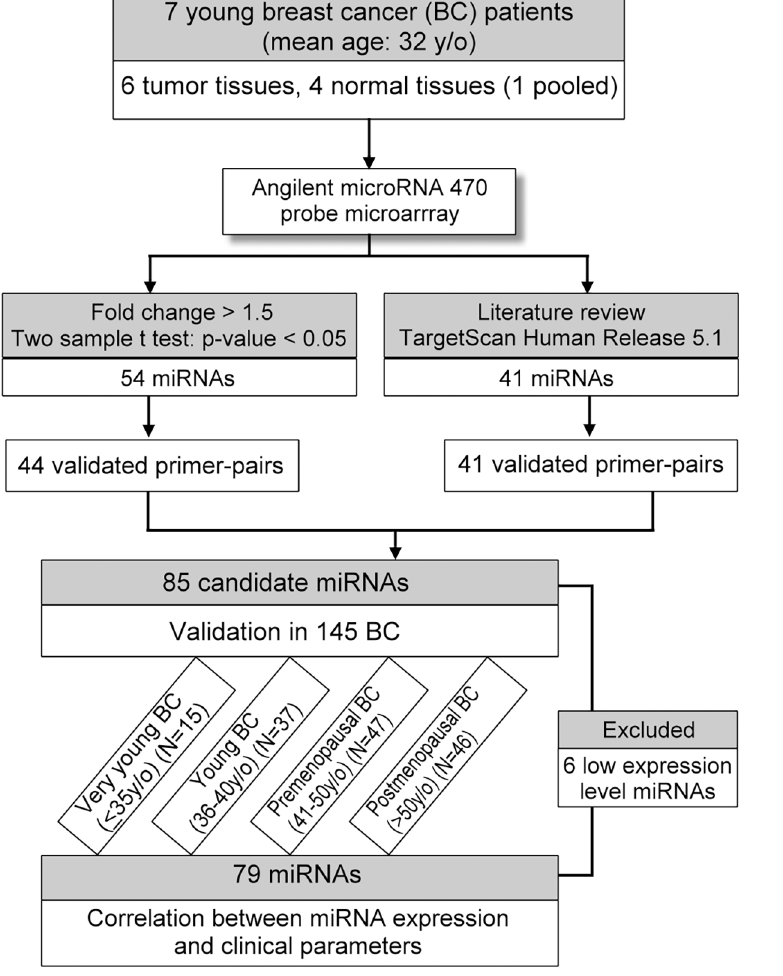
Fig 1. Flow chart diagram of the study